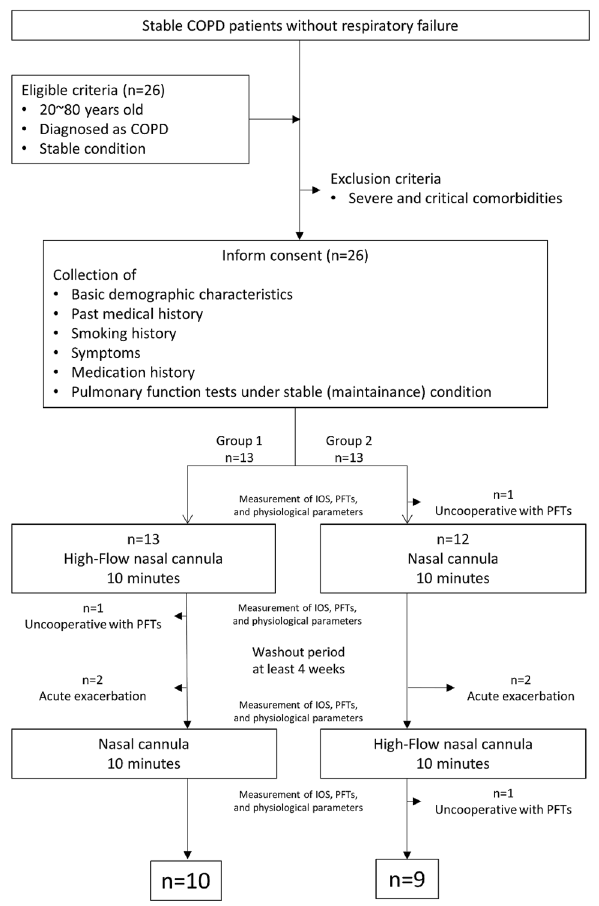
Figure 1. Flowchart of participant